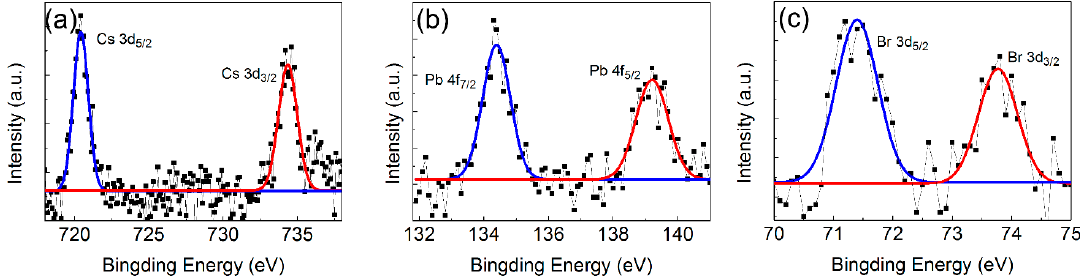
Figure 6. High resolution XPS analyses of QDs-M corresponding to ( a ) Cs 3d; ( b ) Pb 4f; and ( c ) Br 3d.